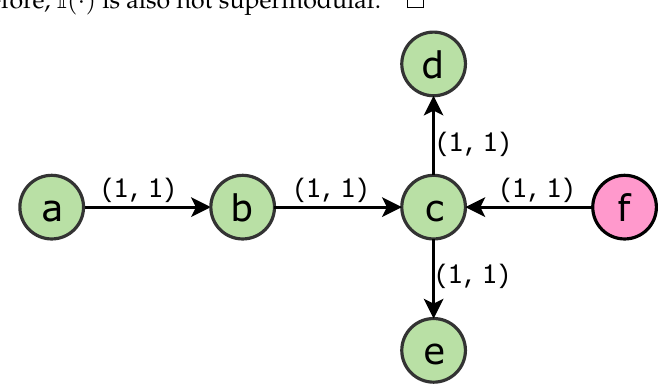
Figure 2. A counter